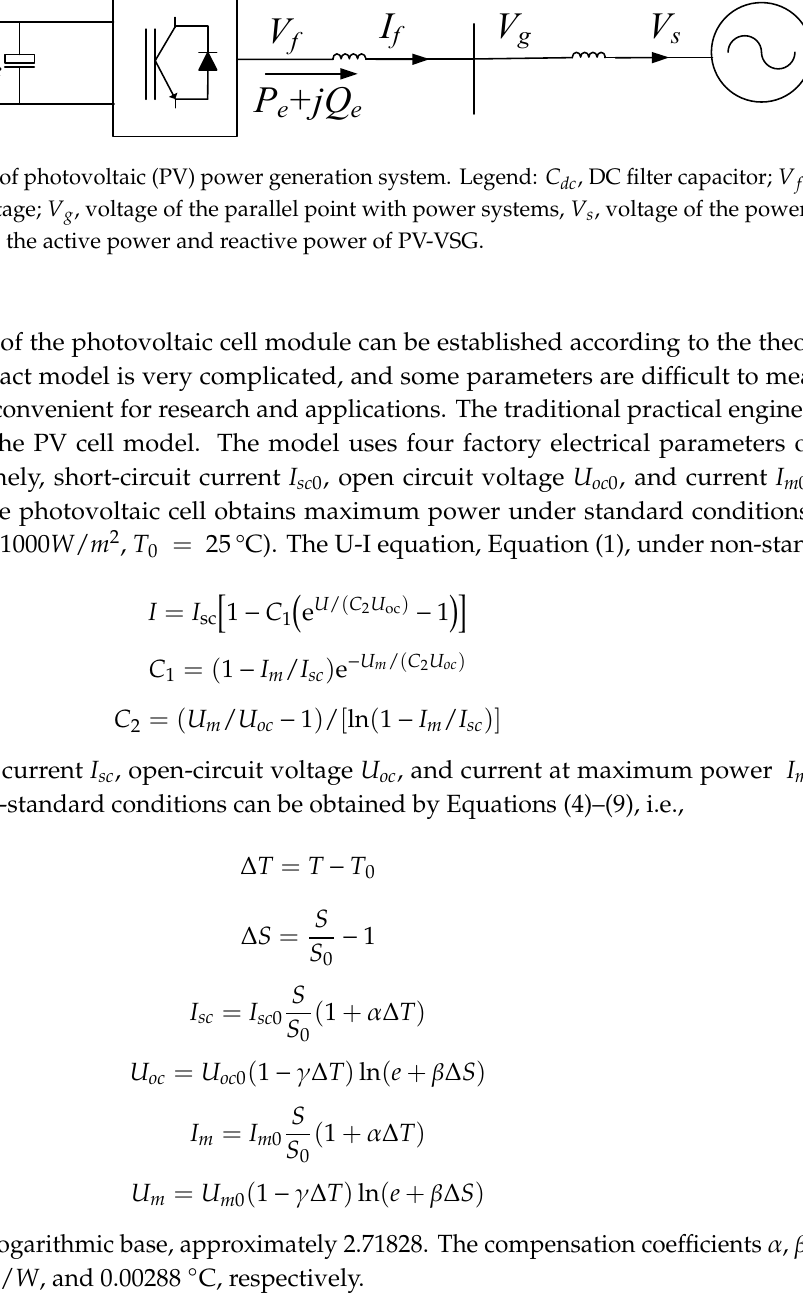
C , DC filter capacitor; dc V , voltage of s